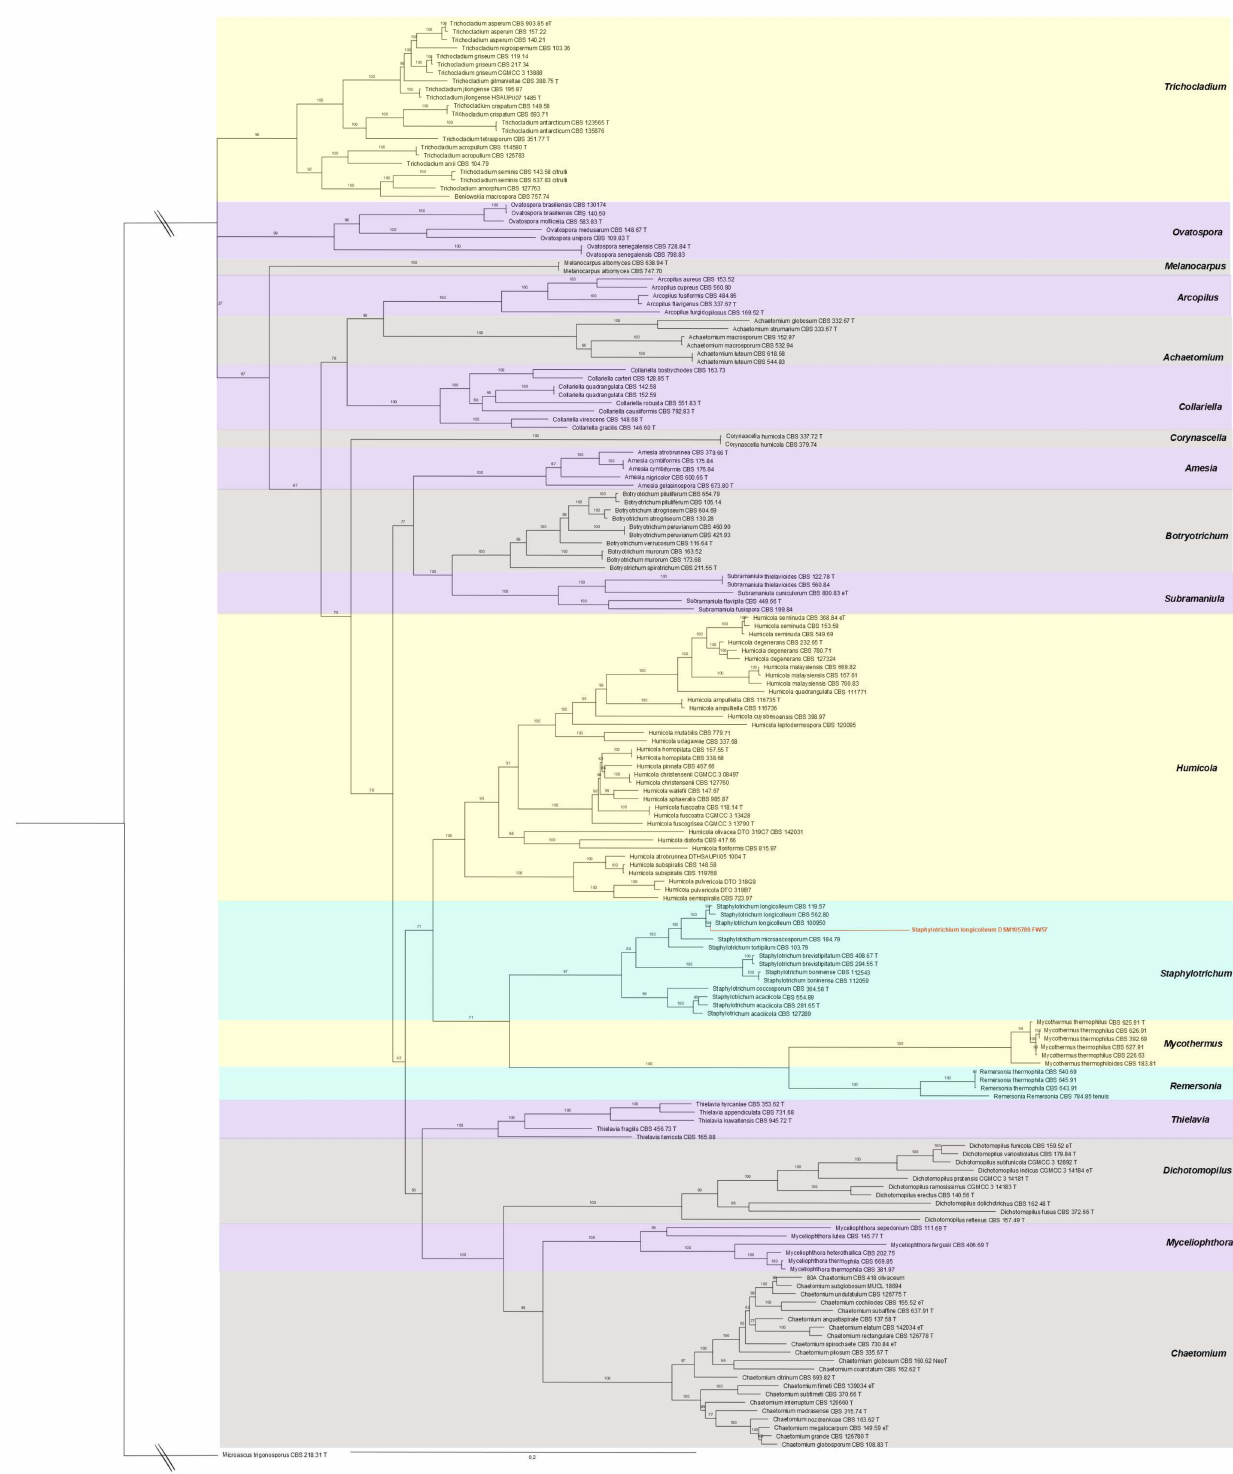
Figure 2. Phylogenetic tree of 173 species of the genus Chaetomiaceae plus FW57, estimated by partitioned maximum likelihood bootstrapping. Numbers at internal nodes indicate branch support based on 5000 data pseudo-replicates in IQTree. The tree was rooted at Microascus trigonosporus strain CBS 218.31 (redefining Humicola sensu stricto and related genera in the Chaetomiaceae ). The alignment holds 3264 columns and 1802 distinct patterns, of which 1354 are parsimony-informative, 409 are singletons, and 1501 are constant